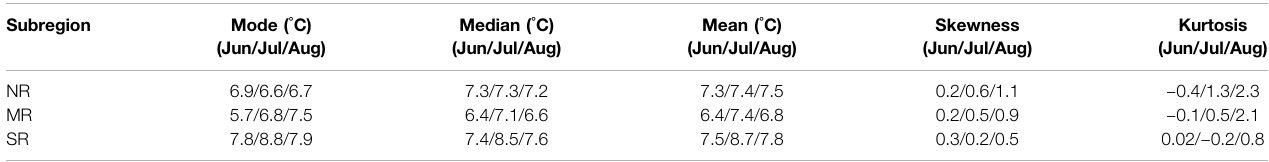
TABLE 1 | Statistics of the DTR in three YRDUA sub-regions in June, July and August.